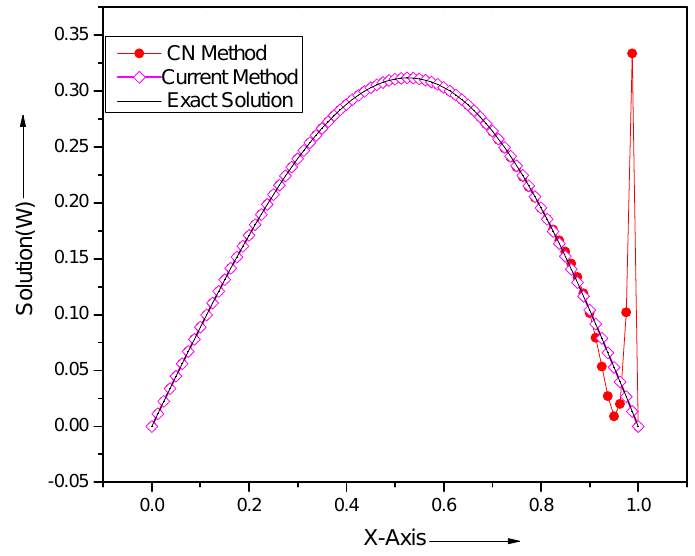
Figure 13. Comparison of analytical solutions and numerical solutions by our method and Crank–Nicolson (CN) method for the problem 5.5 at T = 0.1 for ∆ x = 0.0125, ν d = 2, and τ =